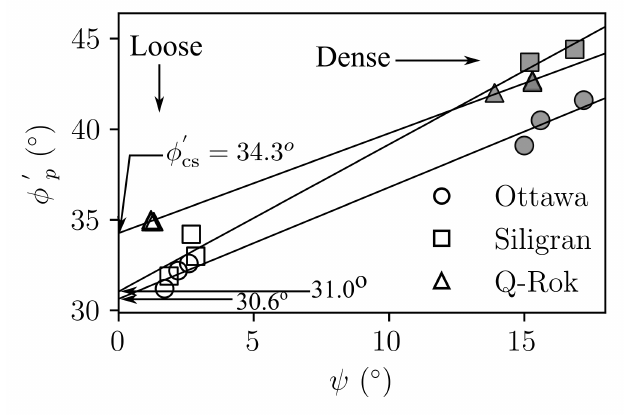
Figure 15. Determination of critical state friction